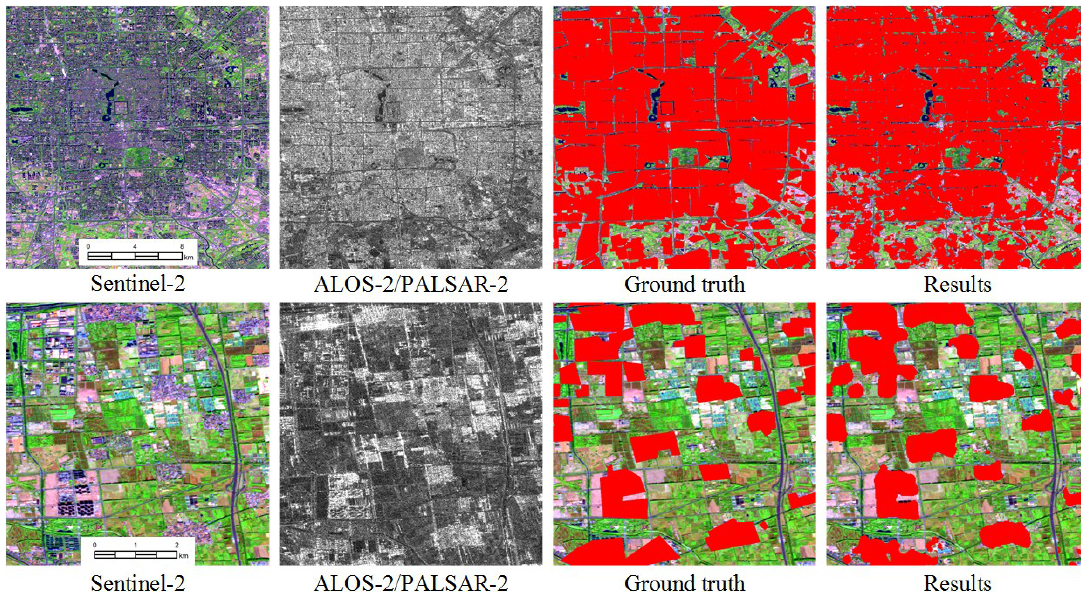
Figure 14. Extraction results based on the proposed method using ALOS-2/PALSAR-2 data.